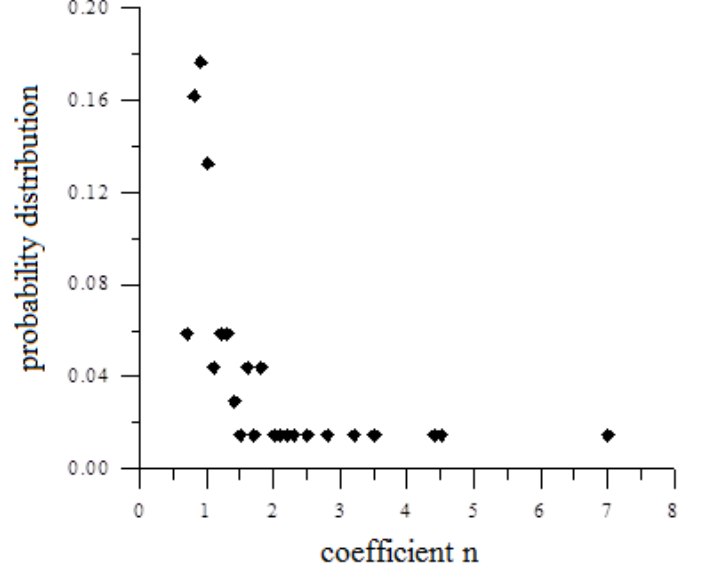
Figure 4. Probability distribution p( n ) of dried leek.